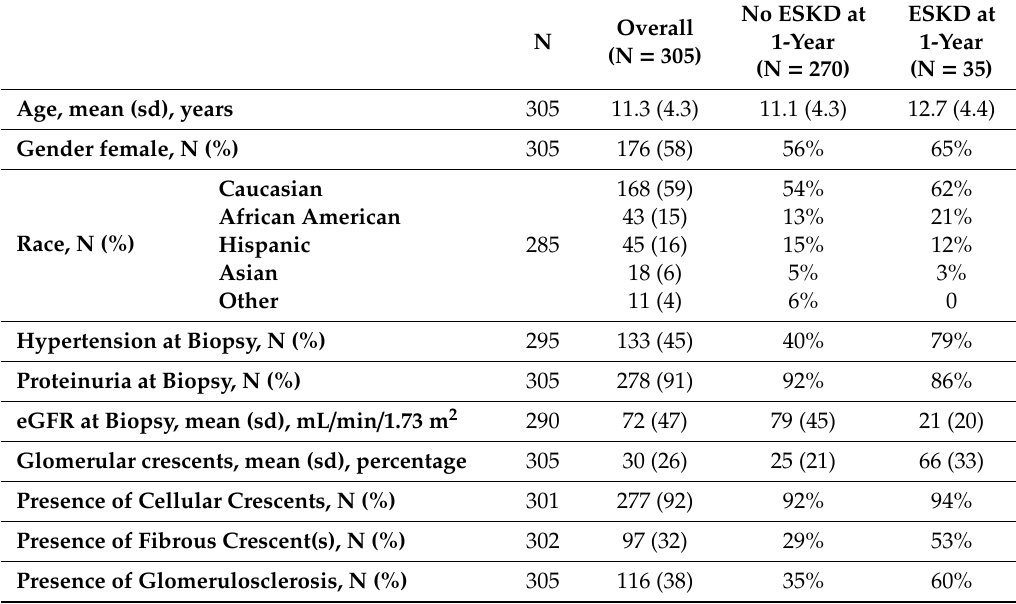
Table 1. Characteristics of children with crescents on kidney biopsy with renal survival compared to those with end-stage kidney disease (ESKD) at one year post